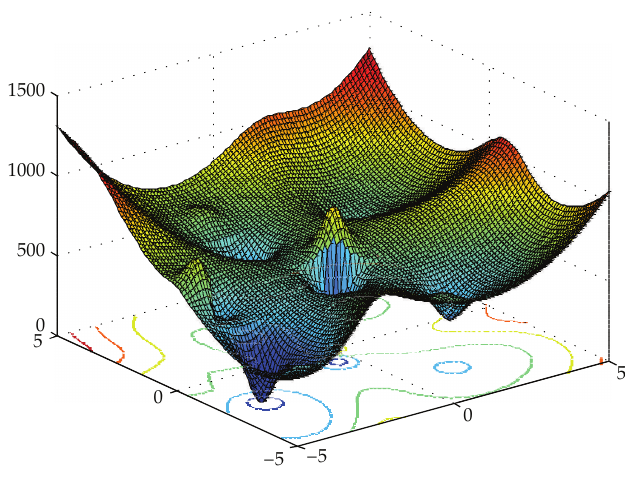
Figure 3: The landscape maps of CF1